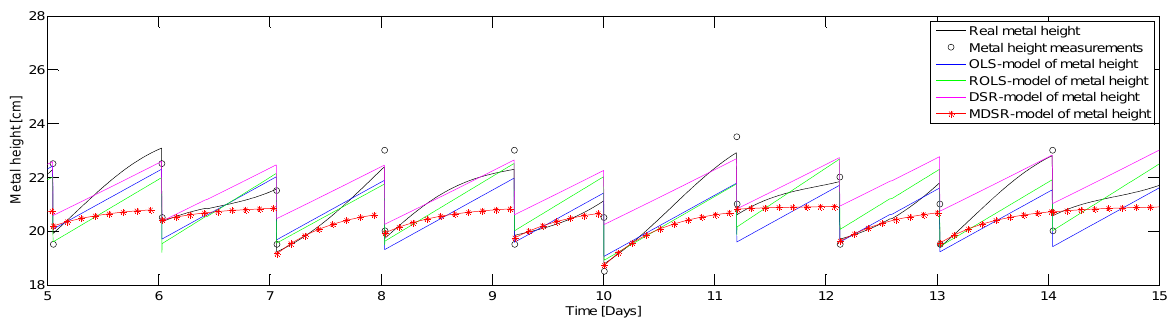
Figure 12: Simulations of the different models, based on the validation data set. The OLS and ROLS predictions are following the “real” metal height quite well, in spite of the large measurement uncertainty. The DSR has a tendency of drifting away as it is not updated by the new metal height measurements, as in the case of the former models. The MDSR has problems in reproducing the system dynamic, but updates the predicted metal height very well at each new measurement.